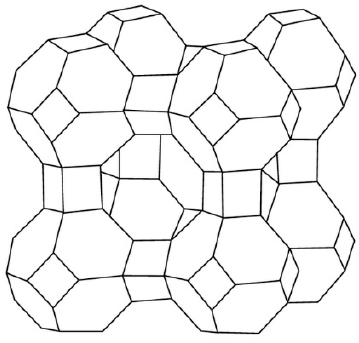
Figure 7. Schematic drawing of the structure of zeolite A. Reproduced from Reference [76] under CC BY 4.0.